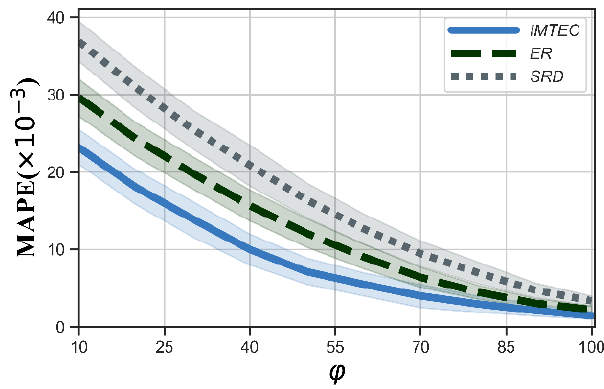
Figure 4. MAPE versus ϕ .